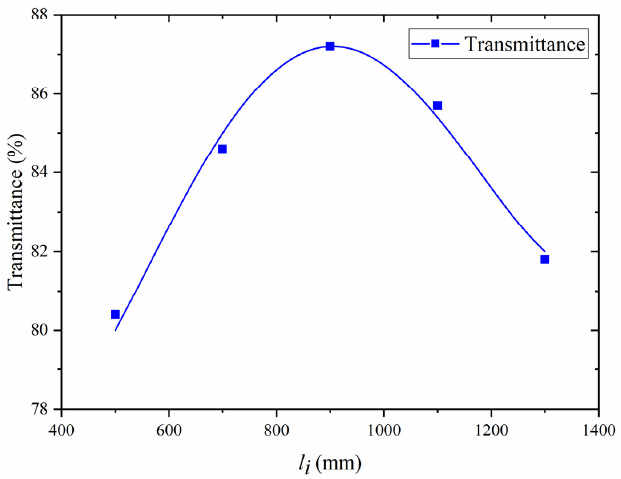
Figure 7. The seed power transmittance when l i = 500 mm, l i = 700 mm, l i = 900 mm, l i = 1100 mm and l i = 1300 mm.